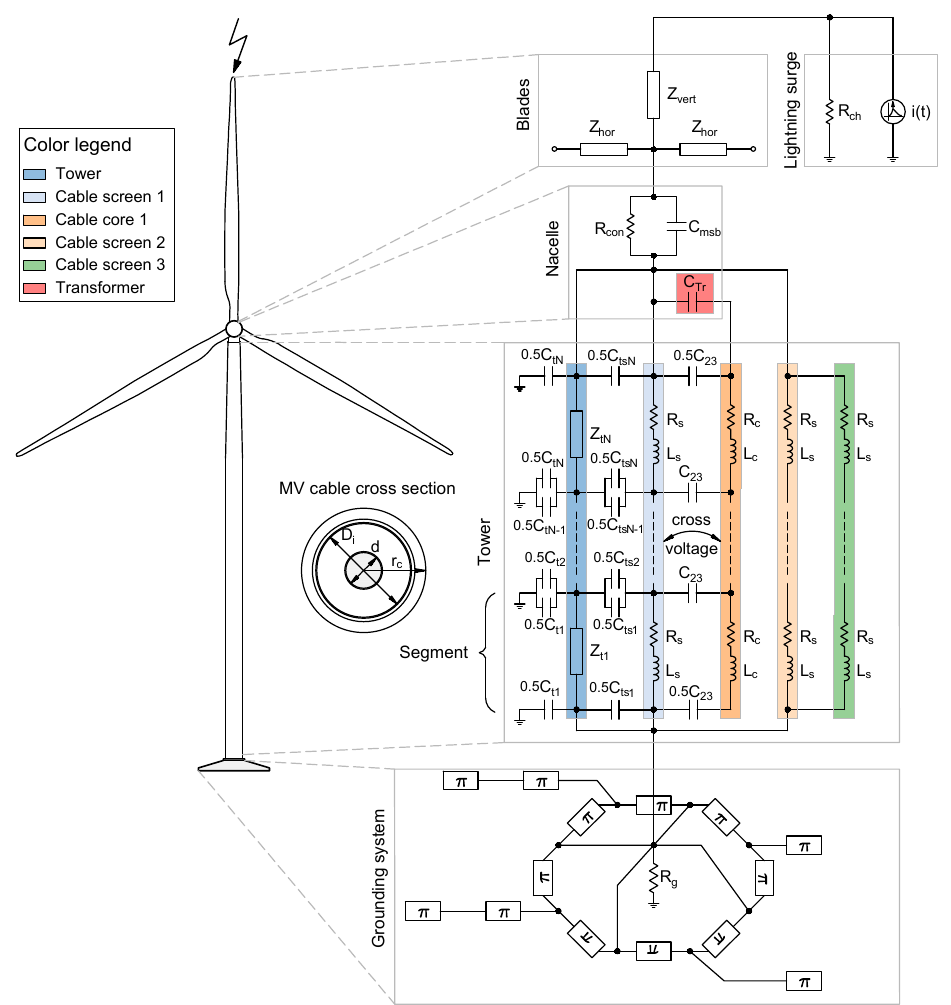
Figure 1. Basic outline of the wind turbine (WT) model for a fast-front transient